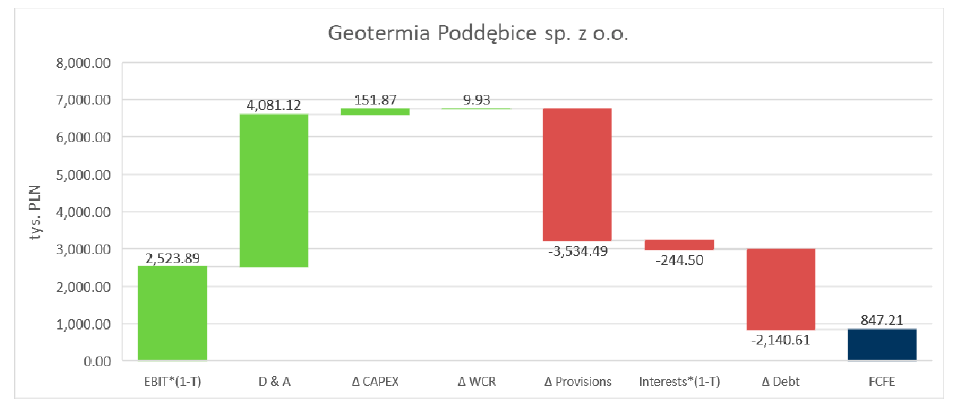
Figure 11. FCFF cash flows generated by Geotermia Podd ę bice Sp. z o.o. in 2016–2019. Source: Own study on the basis of: [52].